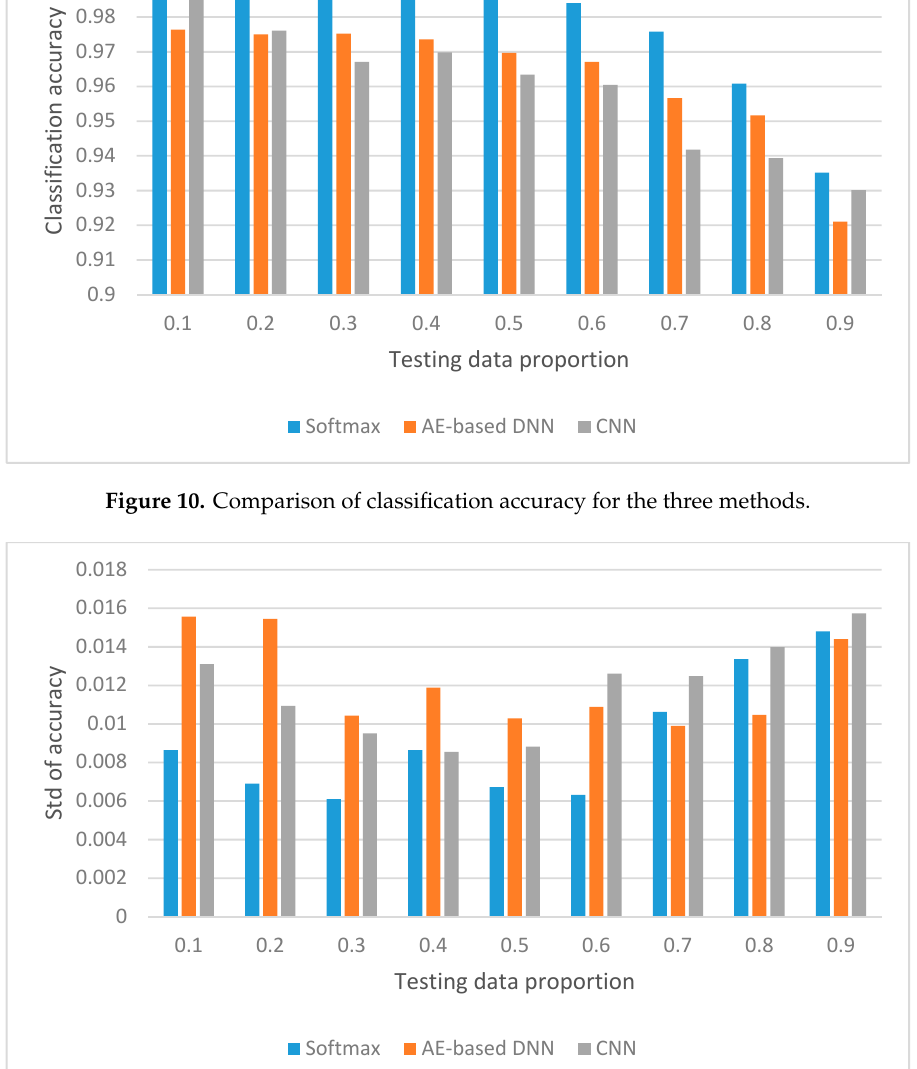
Figure 12. Comparison of speed for the three methods. ( a ) Comparison of training time spent by the three methods, and ( b ) comparison of testing time spent by the three methods. For CNN, the testing time is 0.48 s for 70 examples (testing data proportion of 0.1) and 4.08 s for 630 examples (testing data proportion of 0.9), i.e., the average testing time per example is 0.007 s. For AE-based DNN, the testing time is 0.95 s for 70 examples (testing data proportion of 0.1) and 2.1 s for 630 examples (testing data proportion of 0.9); so, the average testing time per example is 0.004 s. For the SoftMax Classifier, the testing time is 0.11 s for 70 examples (testing data proportion of 0.1) and 0.53 s for 630 examples (testing data proportion of 0.9), i.e., the average testing time per example is 0.001 s. Please note that the time spent is not only to detect fault but also to classify the kind of faults. In these experiments, the stand-alone SoftMax classifier provides better functionality, including fault detection accuracy, classification accuracy, least standard deviation, speed, as well as its strong ability in dealing with high dimensional data. The AE-based DNN has the second best classification ability, but it needs more training time and testing time. CNN has enough classification accuracy, and it needs the least training time.